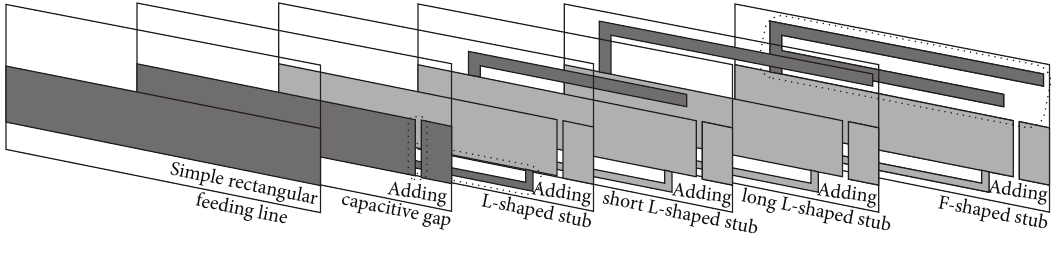
Figure 9: Feeding structure evolution.